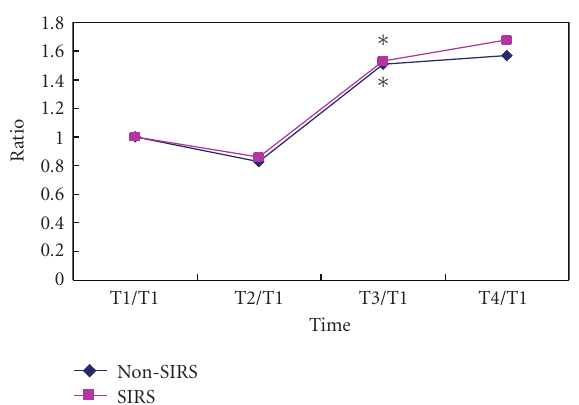
Figure 6: Increase of serum IL-1 β . Median (Q) ( n = 12 for SIRS; n = 15 for non-SIRS); ∗ P < . 05, compared with T1/T1.